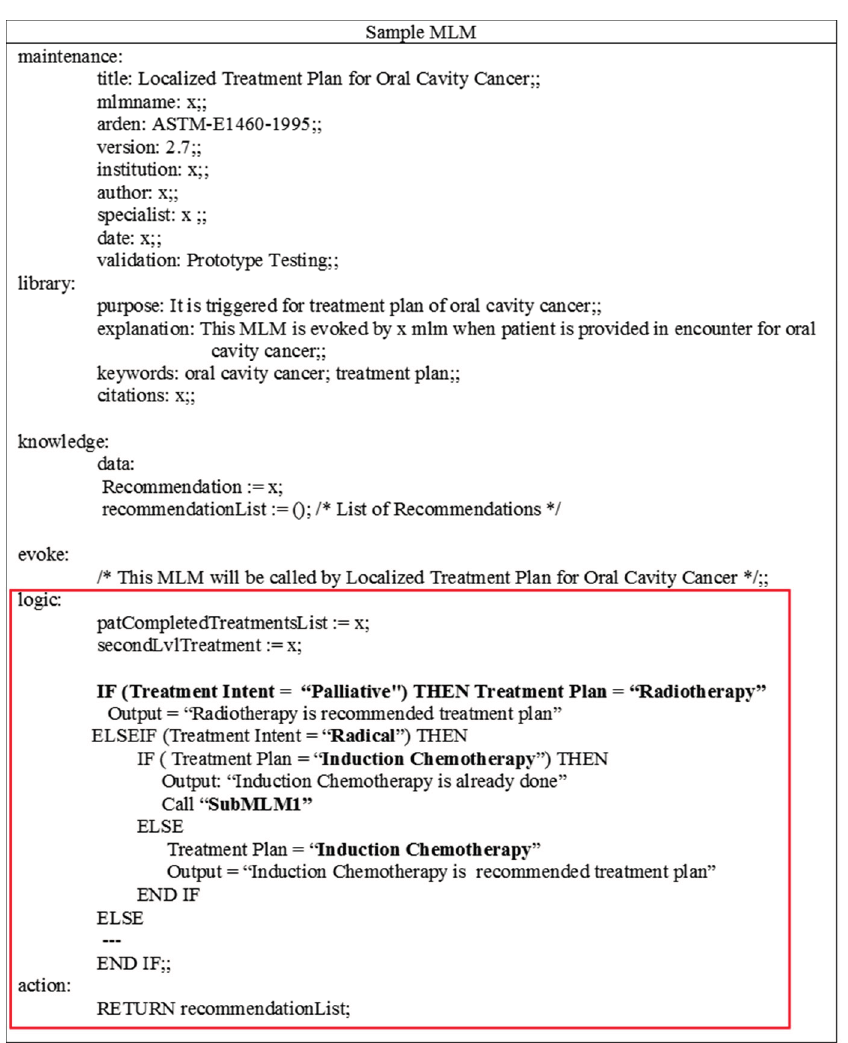
Figure 2. Sample MLM for oral cavity cancer with highlighted “logic” slot in the knowledge